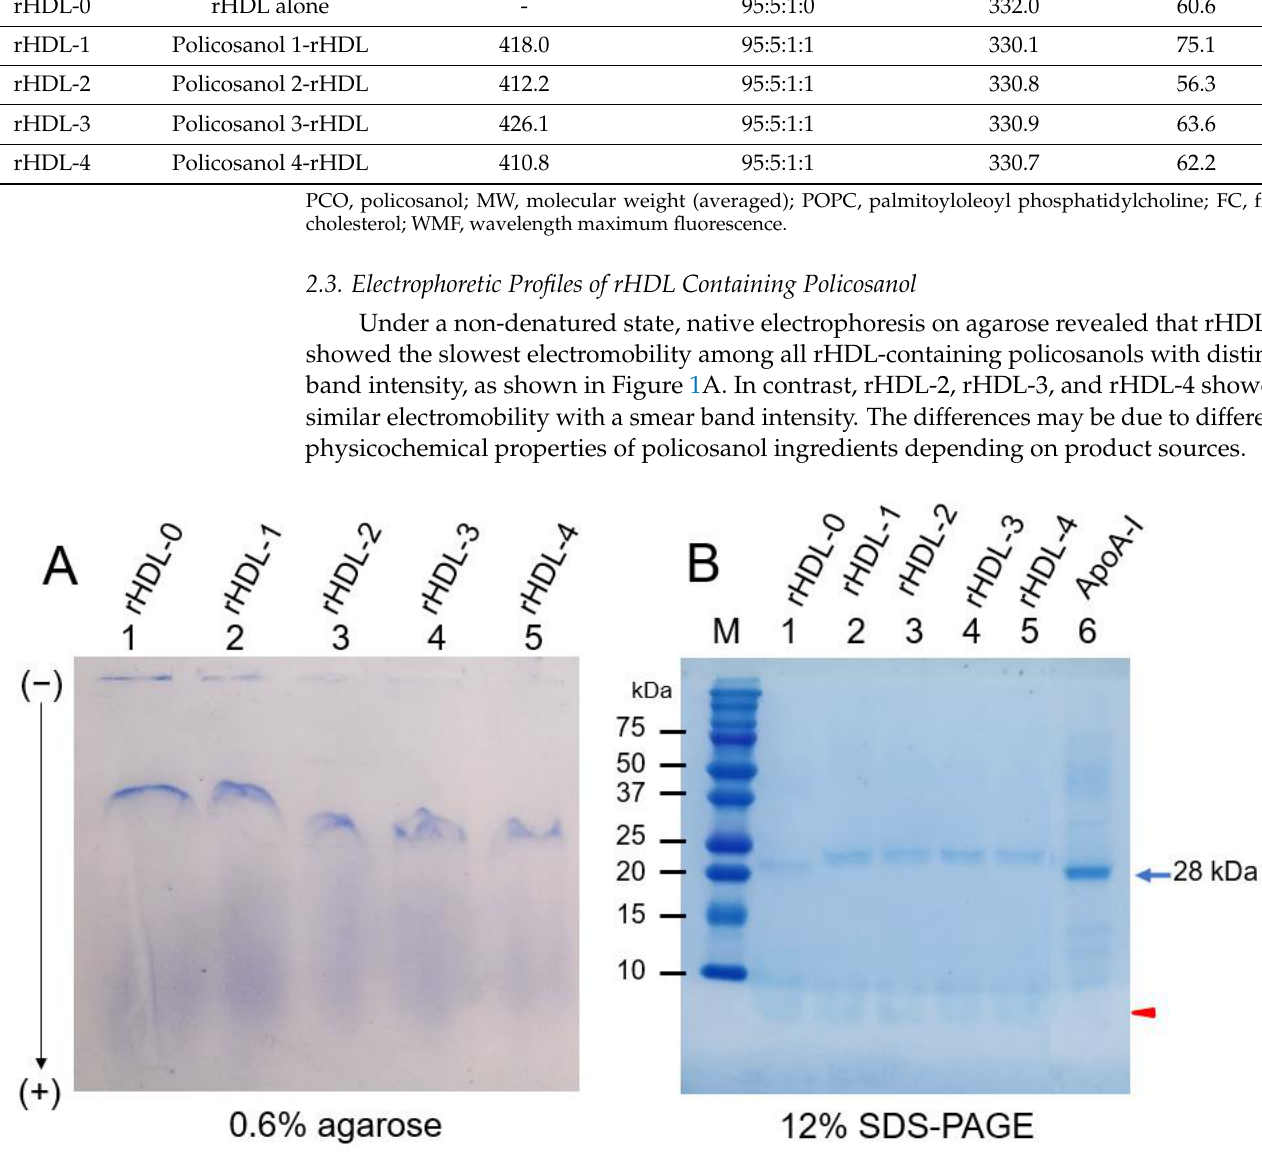
Figure 1. Electrophoretic profiles of rHDL containing policosanol under denatured state ( A ) and denatured state ( B ). ( A ) Native electrophoresis of each rHDL under the non-denatured state on 0.6% agarose (16 µ g of protein/lane) to compare electromobility depends on the three-dimensional structure of apoA-I/HDL and its oxidation extent. The apoA-I in rHDL was visualized by Coomassie brilliant blue staining (final 1.25%). ( B ) Electrophoretic patterns of each rHDL under the denatured state on 12% SDS-PAGE (5 µ g of protein/lane). The red arrowhead indicates phospholipid debris. M, molecular weight standard (Precision plus protein standards, Bio-Rad Cat # 161-0374). The gel was stained by Coomassie brilliant blue (final 0.125%) staining to visualize apoA-I and phospholipid. There was a difference in band mobility between rHDL-0 and rHDL-1; rHDL-0 showed a different single band intensity, while rHDL-1 showed split bands with a slightly smeared band intensity because of the presence of Cuban policosanol. Furthermore, the